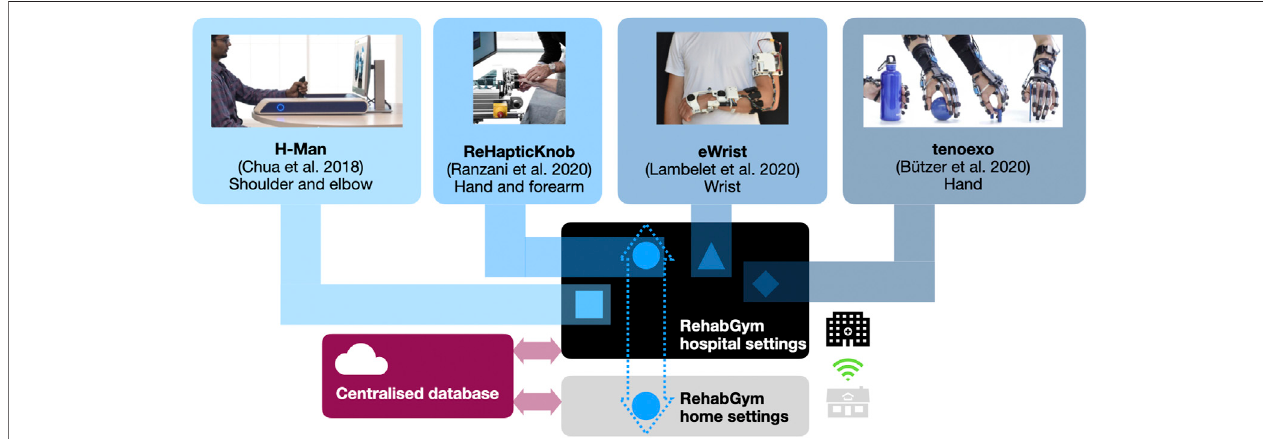
FIGURE 2 | Conceptual overview of a connected RehabGym, with examples of user-friendly and complementary (i.e., targeting all segments of the upper limb) mobile robotic technologies for minimally supervized neurorehabilitation. All technologies are fi rst introduced during inpatient rehabilitation at the hospital, and selected technologies (e.g., the one(s) best adapted to the impairment level and rehabilitation goals of a patient) are taken home upon discharge. Connected devices ensure asynchronous (i.e., not online/real-time), remote communication with healthcare professionals for monitoring purposes.